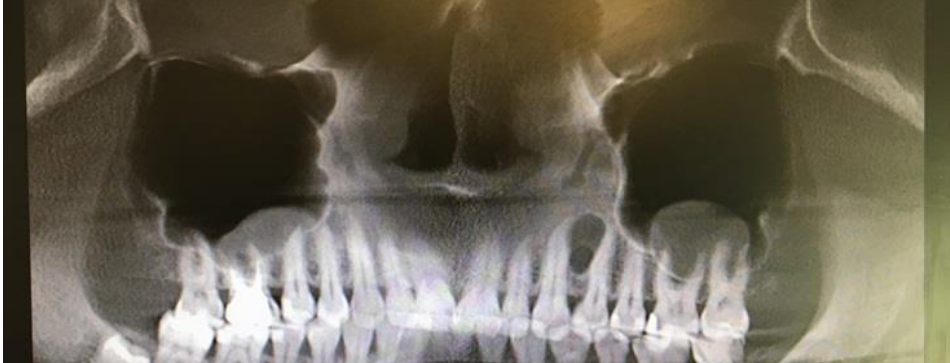
Figure 1. Panoramic radiograph slice from CBCT evaluation of LPC.